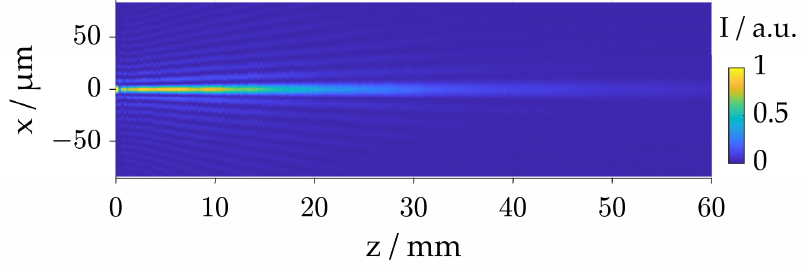
Figure 5. Measured intensity distribution in propagation direction of the Bessel beam behind lens 3.